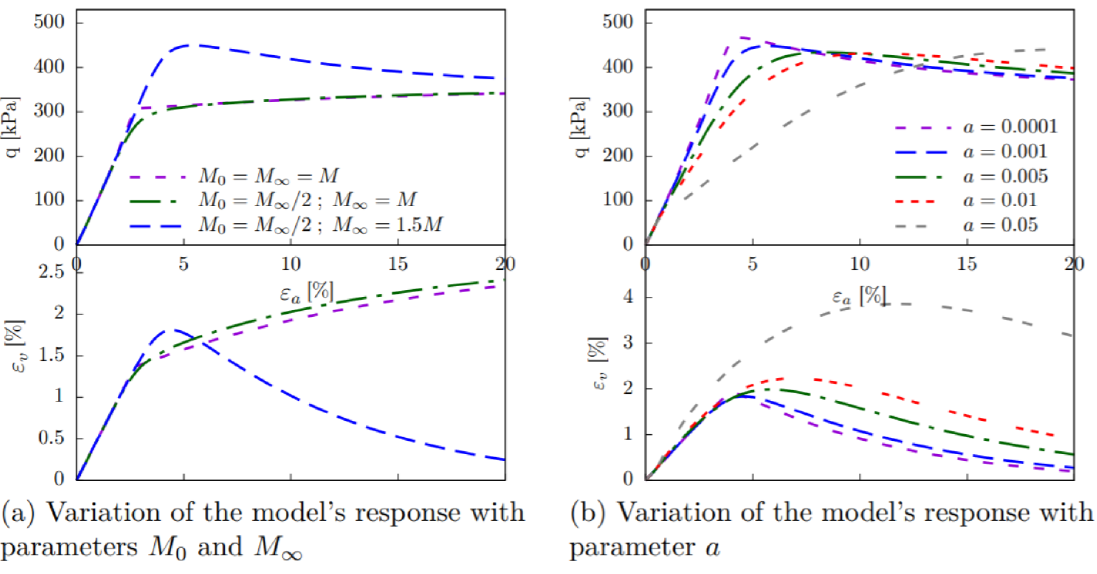
Figure 3: Response of a drained triaxial test. Table 1: Reference material parameters. initial void ratio is 0 . 72.